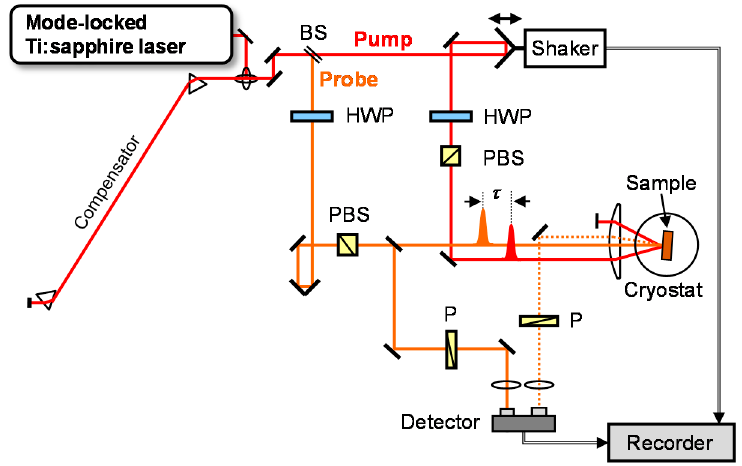
Figure 1. Schematic diagram of the setup for time-resolved reflection-type pump-probe spectroscopy.